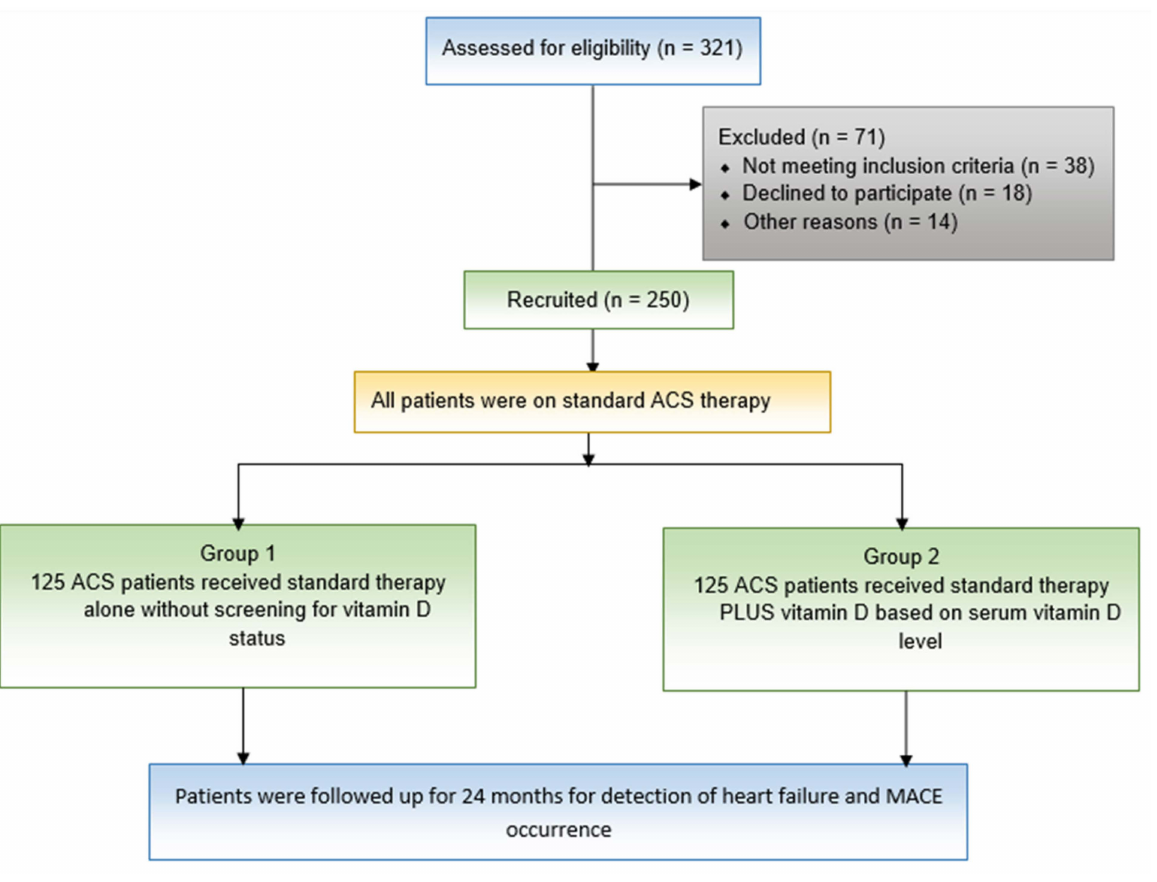
Figure 2. Flow chart show studied patients’ recruitment in the